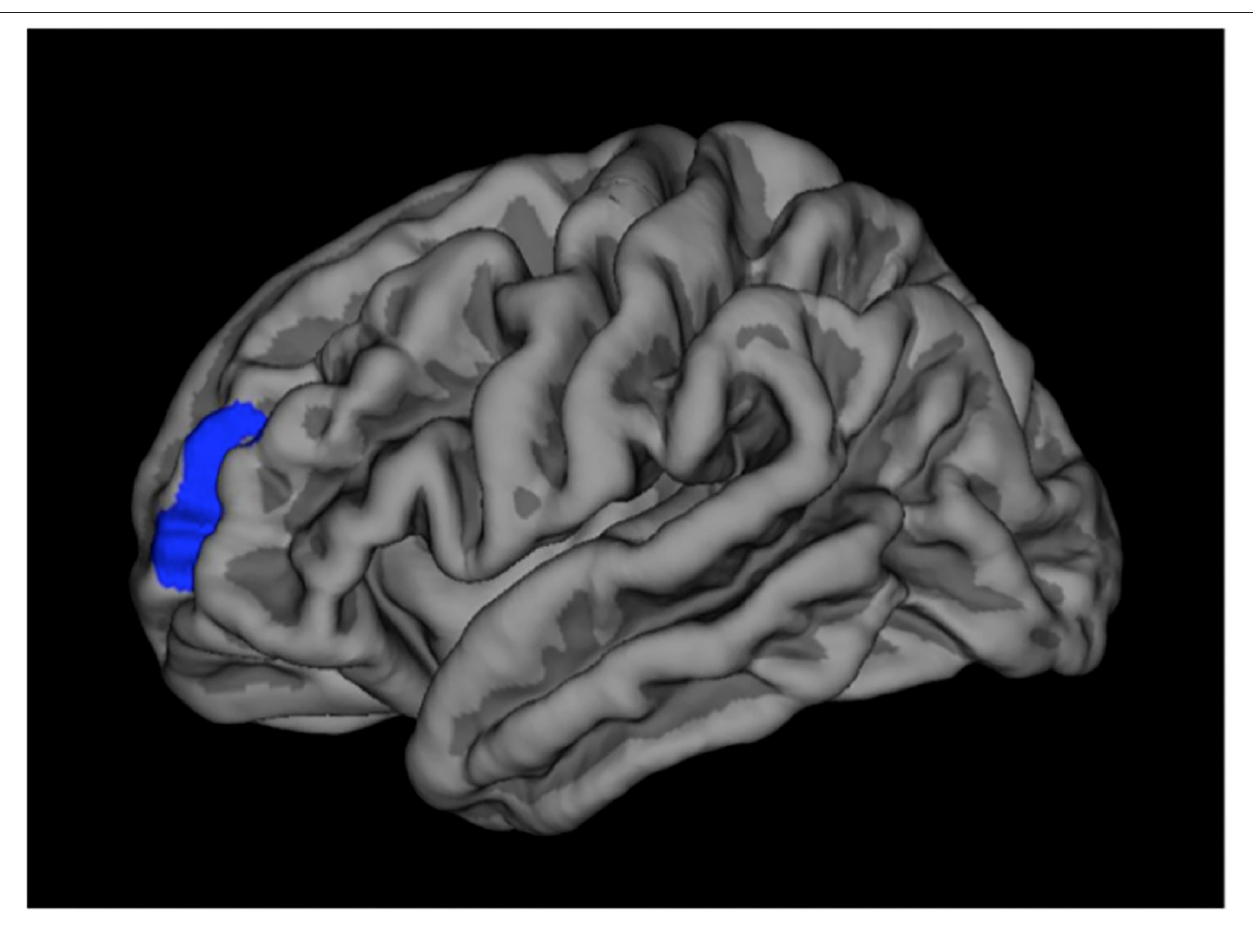
FIGURE 2 | Cortical